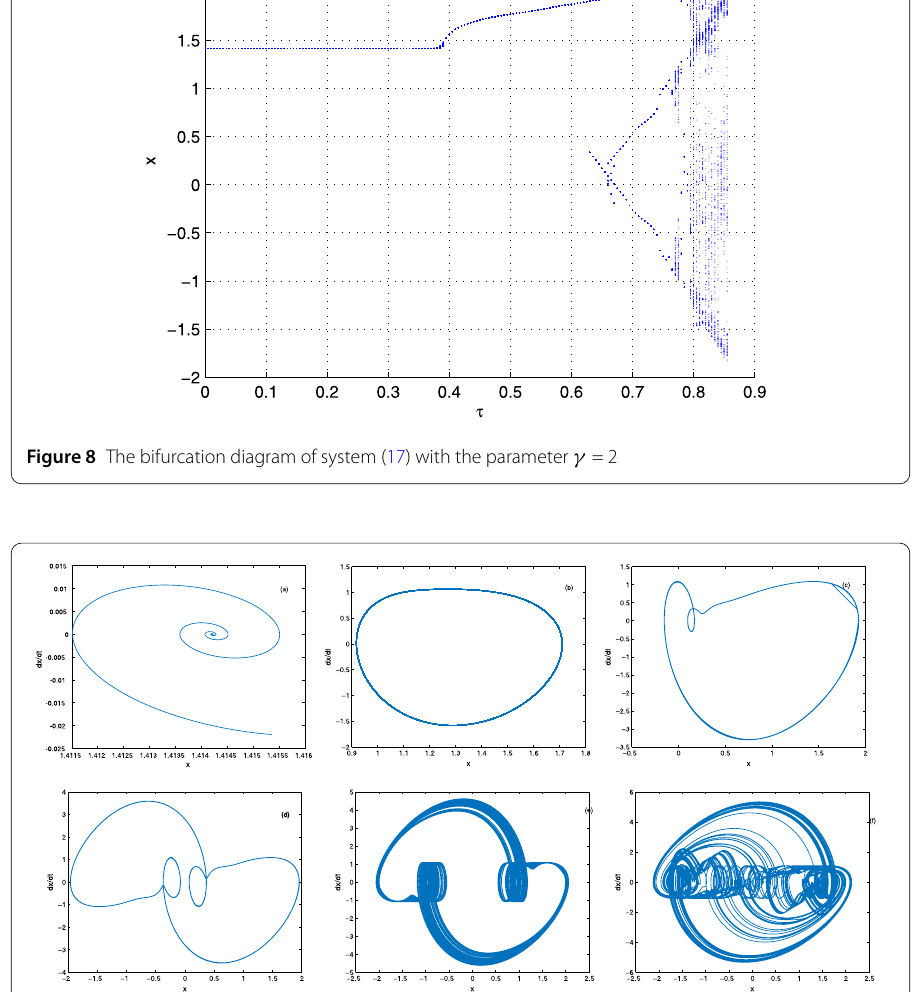
is asymptotically stable for τ ∈ [0,0.31). And the limit cycle of period-1 becomes unsta- ble and a period-2 cycle appears at τ = 0.51. Further period doubling occurs at τ = 0.53 (period-2 to period-4). Through a period doubling sequence, the system enters into the chaotic region at τ = 0.61. Then, the system becomes divergent at τ = 0.69. A phase plane representation in the representative x – dx / dt plane for different τ is shown in Fig. 11, which shows the following characteristics: stability ( τ = 0.2), period-1 ( τ = 0.36), period-2 ( τ = 0.52), period-4 ( τ = 0.54), and chaos ( τ = 0.62 and τ =